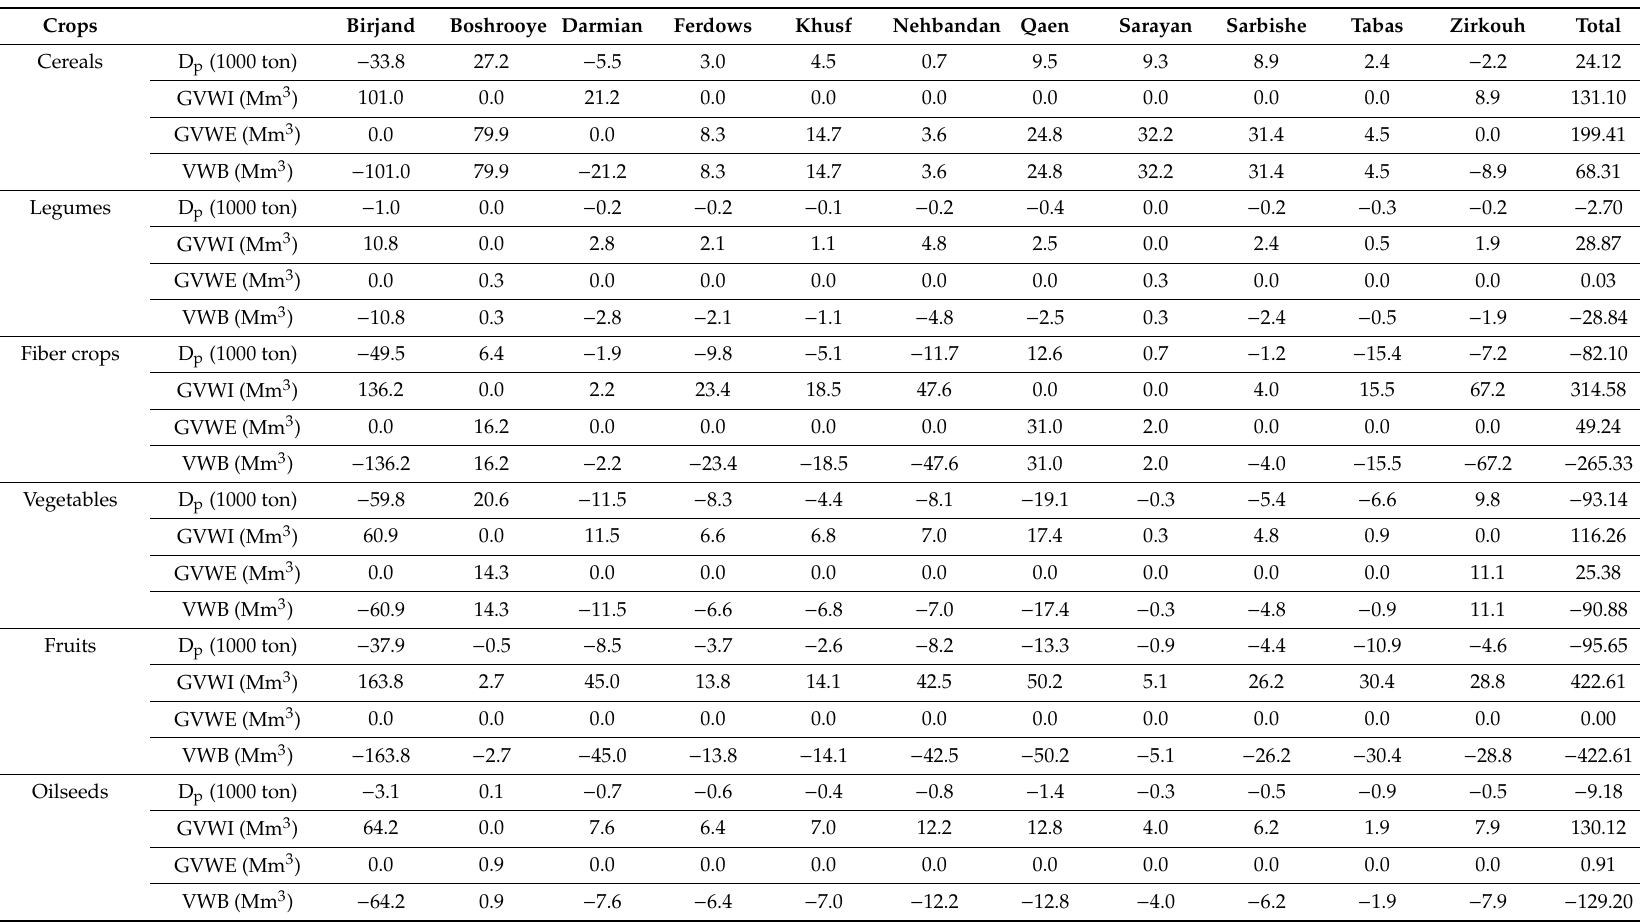
Table 4. Comparison of 10-year average Gross Virtual Water Import (GVWI) and Gross Virtual Water Export (GVWE) of 11 counties in crops. Crops